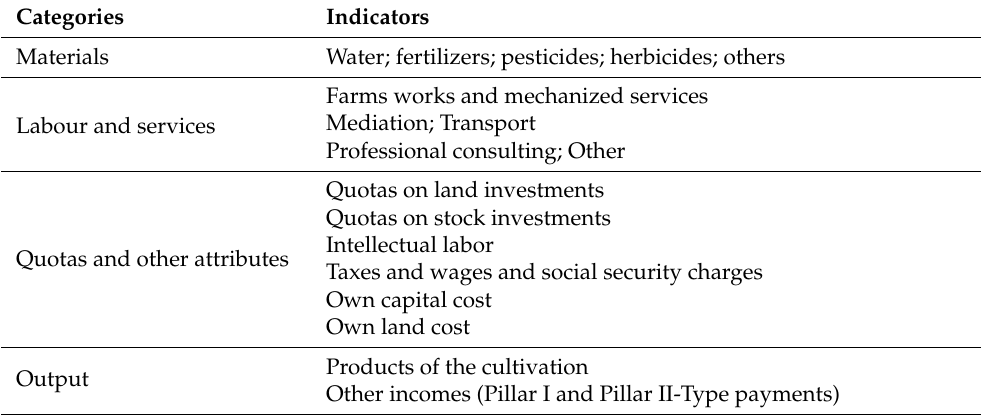
Table 3. Production cost